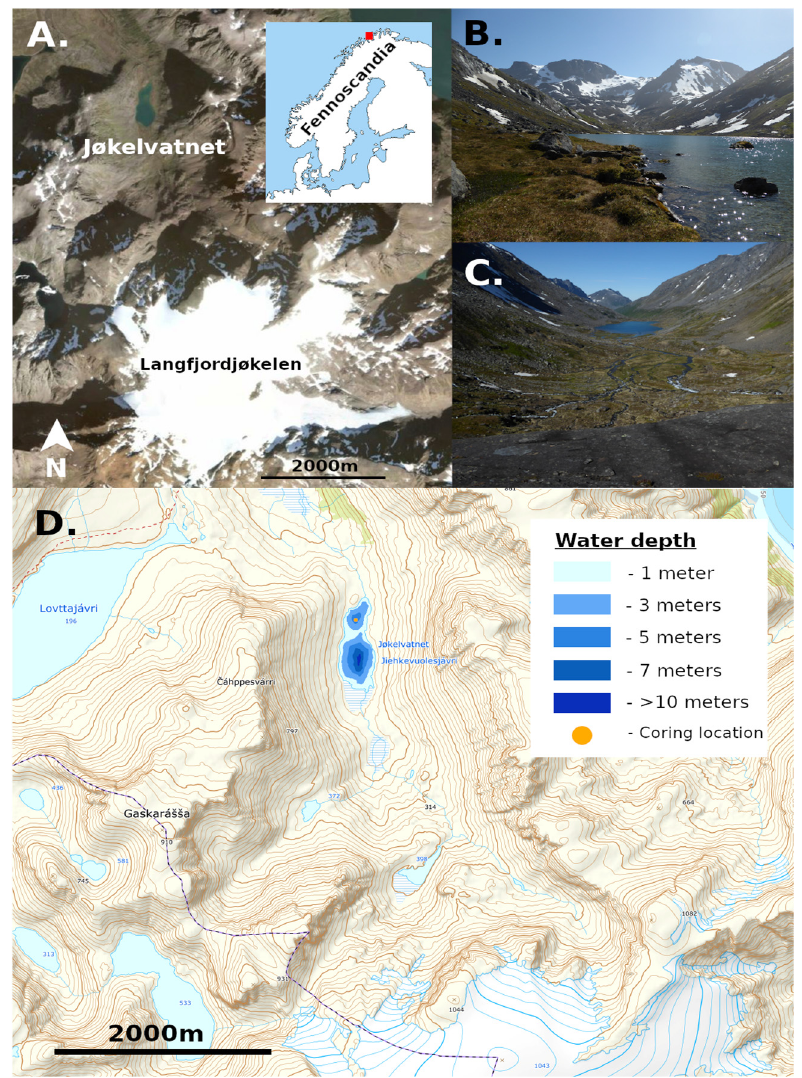
Figure 1. ( A ) Satellite image (norgeskart.no accessed 29 April 2022) of Lake Jøkelvatnet and the Langfjordjøkelen glacier with inset map of Fennoscandia. ( B ) View looking south towards the glacier from the northern outlet of the lake. ( C ) View looking north over the lake from near the glacier. Photographs taken by I. G. Alsos in July 2021. ( D ) Topographic map (norgeskart.no) of the catchment and lake bathymetry showing the coring location of JØP-112.